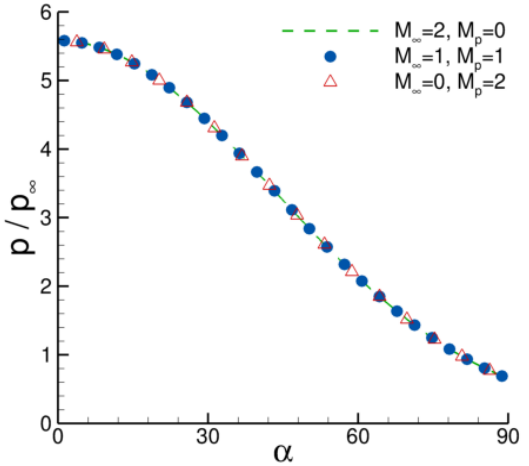
Figure 6. Distribution of the gas pressure along the sphere surface.